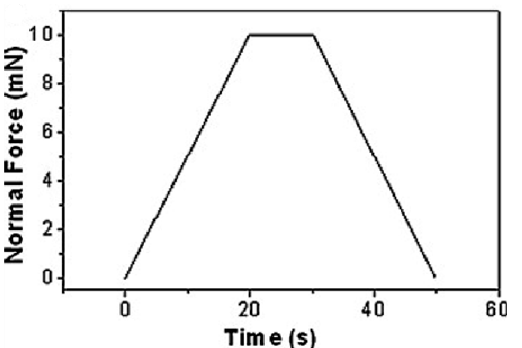
Figure 1. Set ‐ up of the first step of the calibration protocol used on Fq, Sa, and Pc, consisting of a trapezoidal load functions with peak dwelling loads ranging from 0.1 to 10 mN.